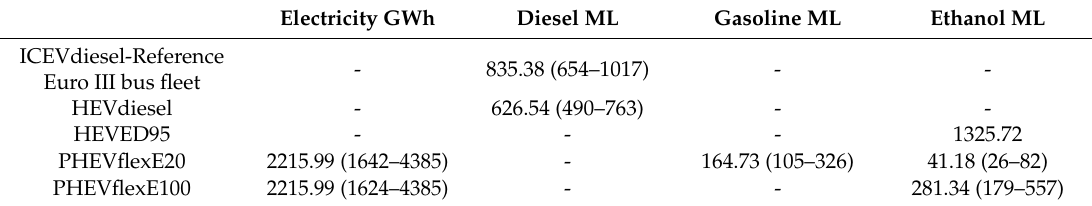
Table 8. Final energy consumption by source and per year, with